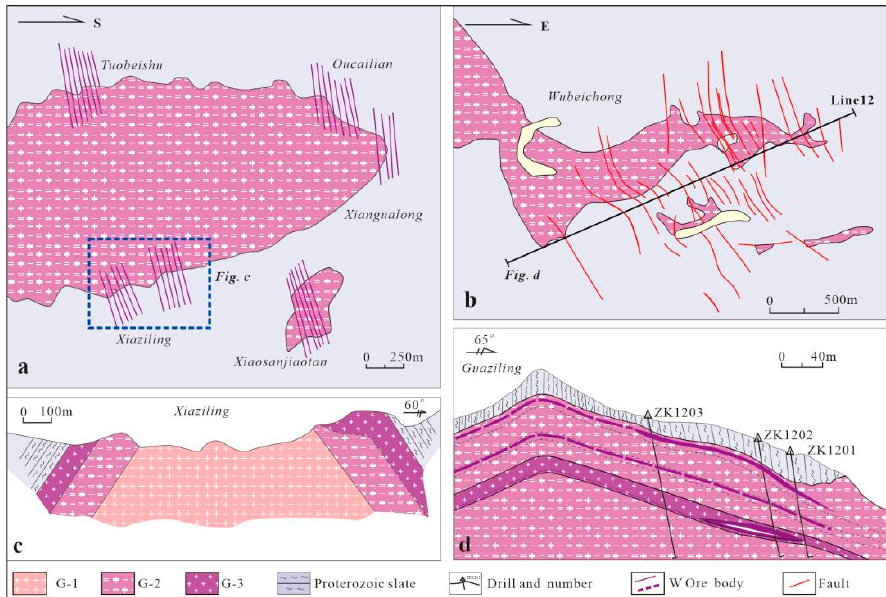
Figure 3. ( a ) Geological map of Sanjiatan deposit, ( b ) Geological map of Wubeichong deposit, ( c ) Geological section map of Xiazilin ore block in Sanjiatan deposit, ( d ) Line 12 profile map of Wubeichong deposit.